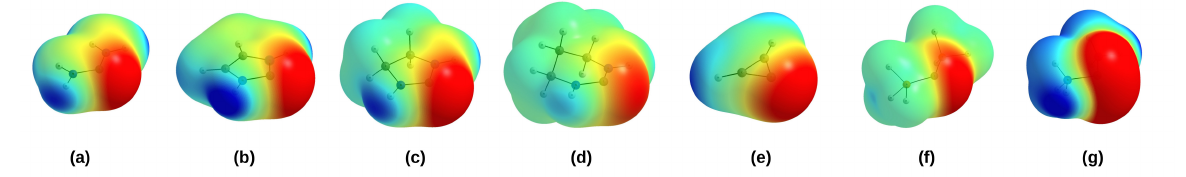
Figure 5. Maps of electrostatic potential projected on 0.001 au isodensity surfaces of carbenes (( a ) (NH 2 ) 2 C, ( b ) imidazol-2- ylidene, ( c ) imidazolidin-2-ylidene, ( d ) tetrahydropyrymid-2-ylidene, ( e ) cyclopropenylidene) and carbodiphosphoranes (( f ) (PH 3 ) 2 C, ( g ) (NH 3 ) 2 C). A common value scale (in au) was used: − 0.06—red, − 0.03—yellow, 0.00—green, 0.03—cyan,